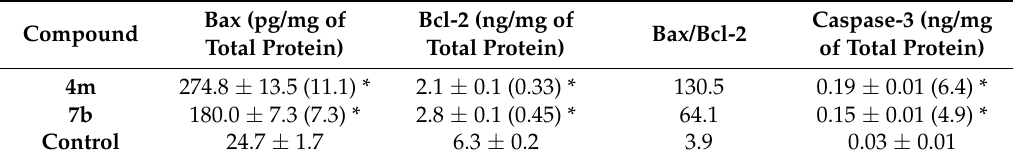
Table 3. Impact of hybrids 4m and 7b on the expression levels of Bcl-2 and Bax and on the active caspase-3 level in MDA-MB-231 cancer cells treated with each hybrid at its IC 50 concentration. Bax (pg/mg of Bcl-2 (ng/mg of Compound Total Protein)